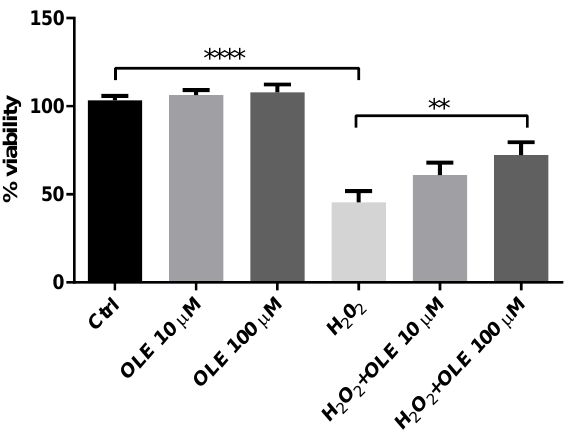
Figure 2. Cytoprotective effect of oleuropein (OLE) on H 2 O 2 -induced damage in HTR-8/SVneo cells. The data are expressed as mean + SEM. ** p < 0.01, **** p < 0.0001.